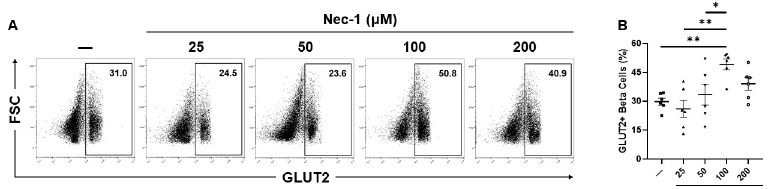
Fig 7. GLUT2 expression in beta cells of islets after 7 days of tissue culture in control media (—) or media supplemented with 4 different doses of necrostatin-1 (25, 50, 100, or 200 μ M of Nec-1) on day 3. 3000 islet equivalents were dissociated into single cells using Accutase, stained with 7-amino-actinomycin D (7-AAD) viability dye, phycoerythrin-conjugated anti-insulin and fluorescein-isothiocyanate-conjugated anti-GLUT2 antibodies, and analyzed by flow cytometry to quantify the expression of GLUT2 in insulin-positive beta cells of islets. GLUT2-positive beta cells were gated on 7-AAD-negative and insulin-positive live beta cells. A) Representative flow cytometry plots of GLUT2 staining. B) Percentage of GLUT2-positive, insulin-positive beta cells. n = 6 for each group. � p < .05. �� p < .01. Data are expressed as mean ±